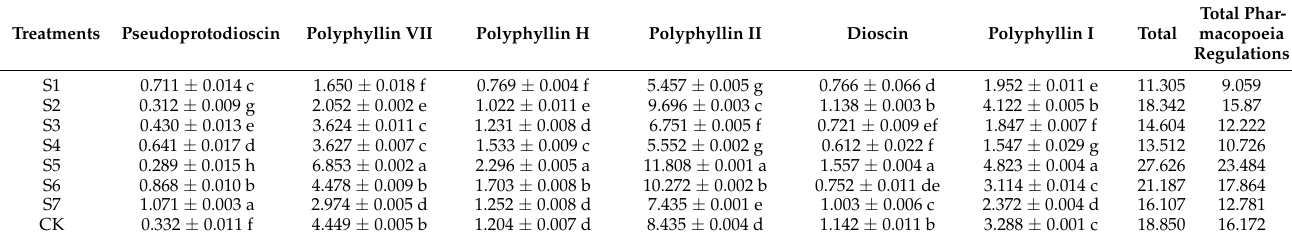
Table 5. Contents of 6 steroidal saponins in the rhizome of Paris polyphylla var. yunnanensis . (mg/g, x ± s , n =